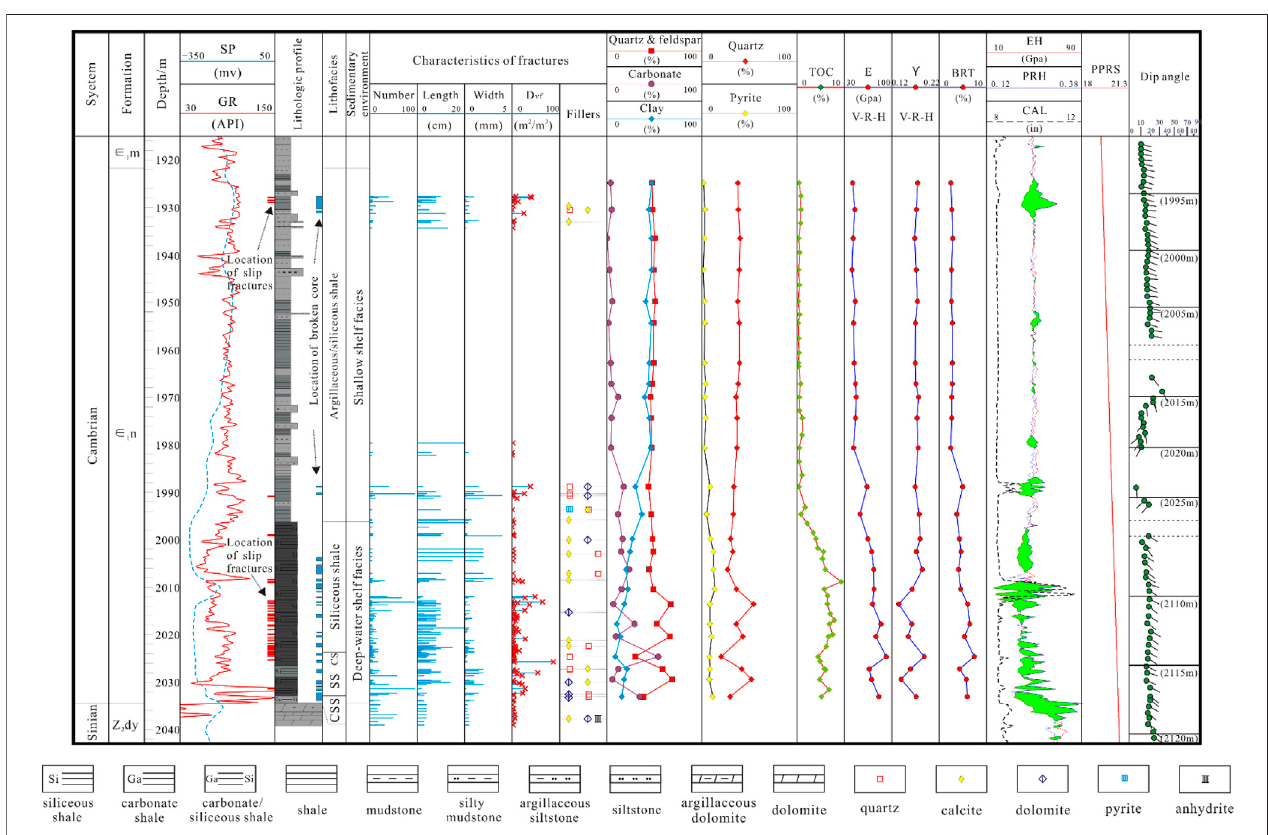
FIGURE 3 | The comprehensive column of the characteristics of shale fracture development in the Niutitang Formation of Well YX1. BRT represents brittleness index, EH represents dynamic Young ’ s modulus, PRH represents dynamic Poisson ’ s ratio, PPRS represents pore pressure and Dvf represents volume density of